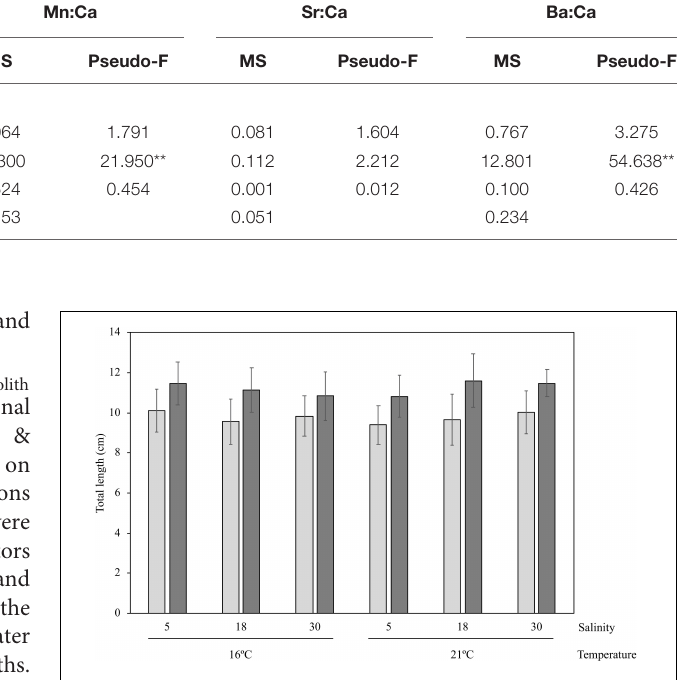
FIGURE 1 | Average total length of juvenile Solea senegalensis at the beginning (light gray) and at the end (dark gray) of the experimental procedure for all